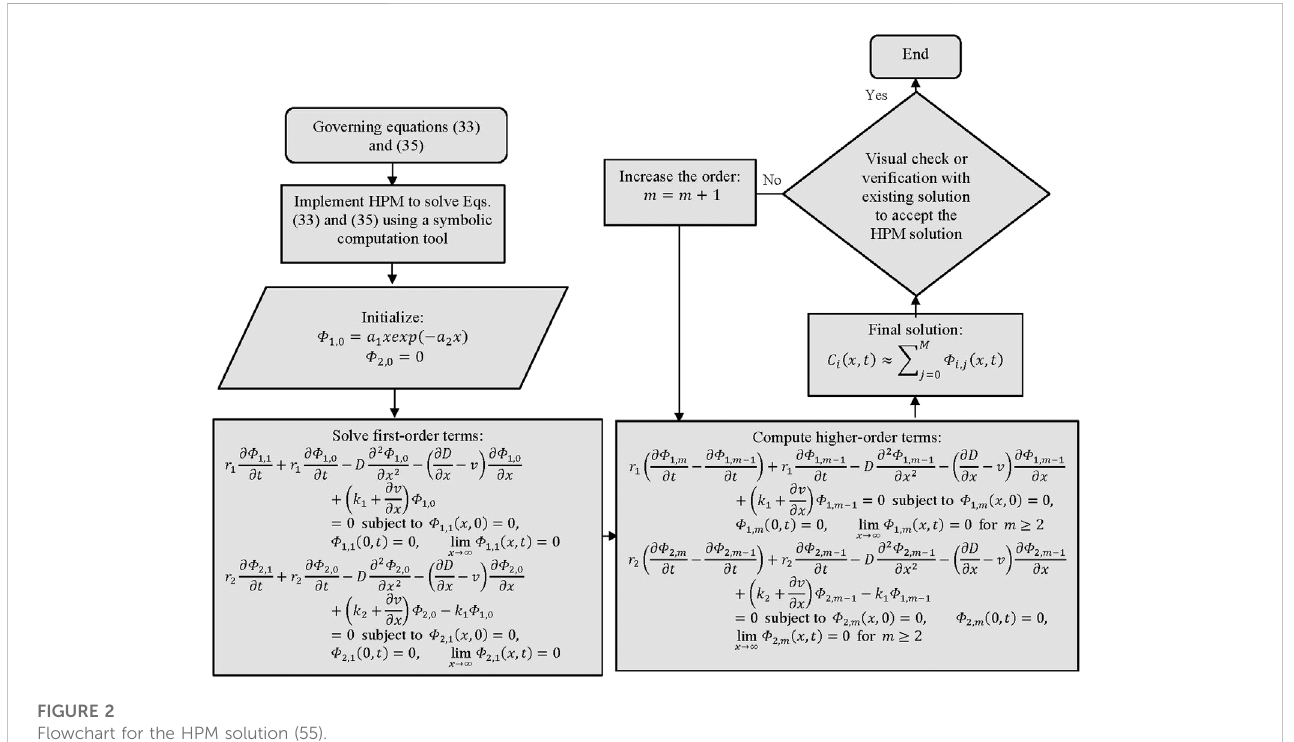
FIGURE 2 Flowchart for the HPM solution